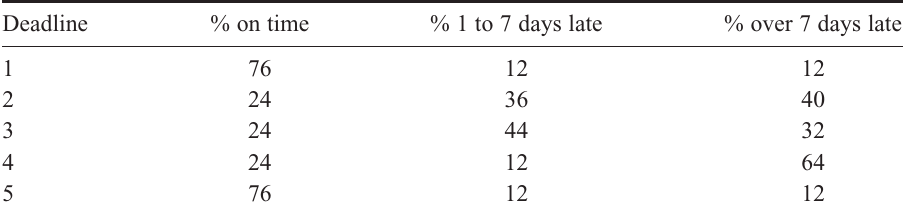
Table 2. Meeting deadlines.